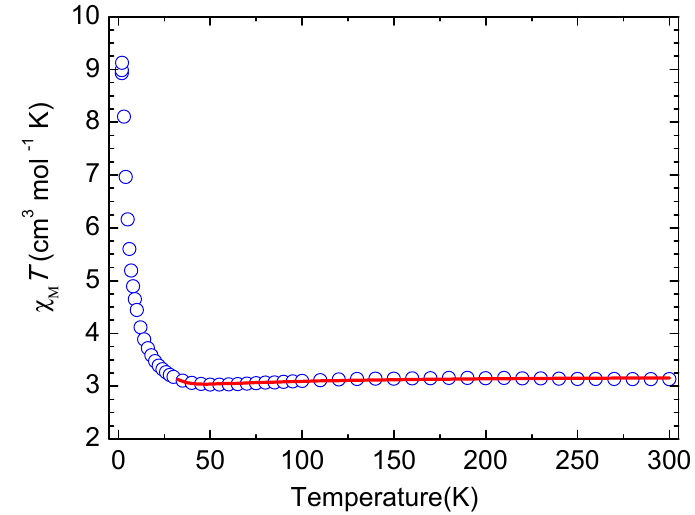
Figure 7. Plot of χ M T vs. T of compound 2 in an applied field of 1 kOe from 2 to 300 K. The solid line represents the best fit.